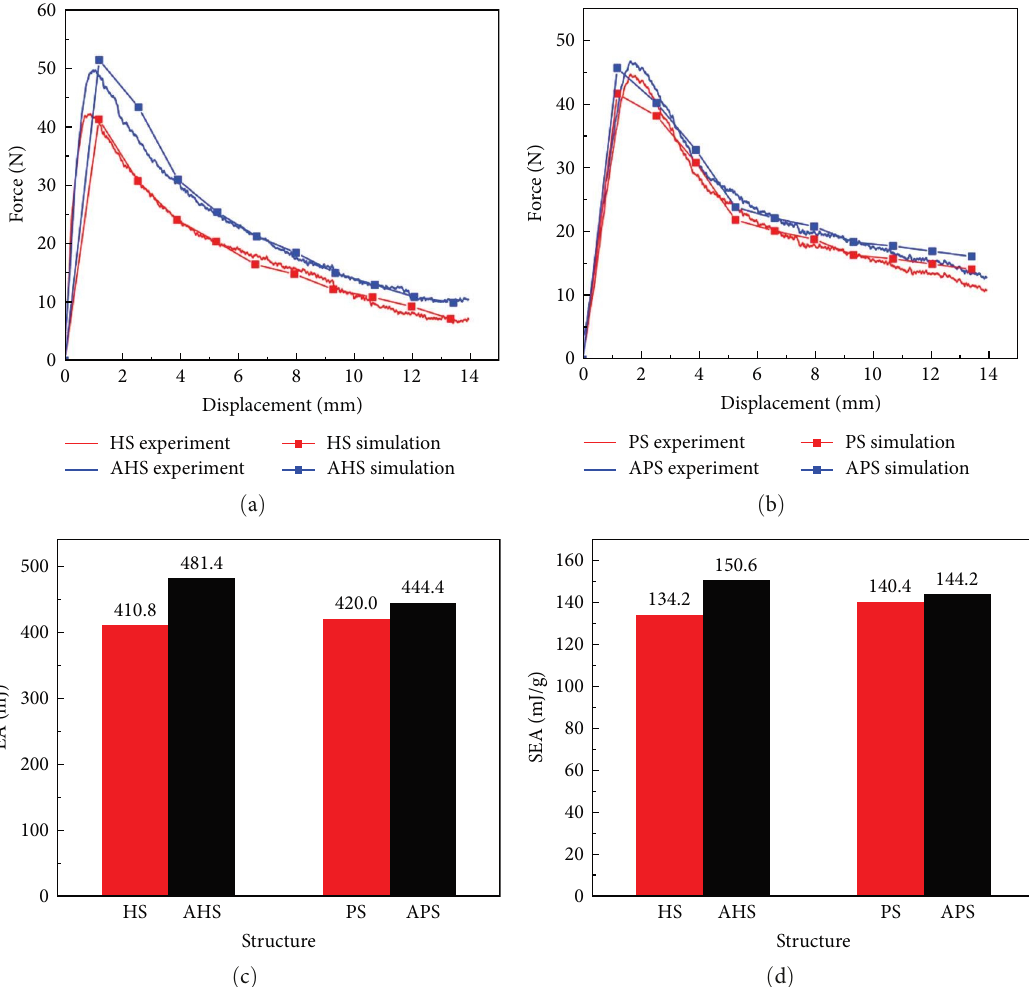
F IGURE 5: The mechanical characteristic curves of bionic structures: (a) the experiment and simulation force – displacement curves of honeycomb structures; (b) the experiment and simulation force – displacement curves of negative Poisson structures; (c) EA histogram of bionic structures; (d) SEA histogram of bionic